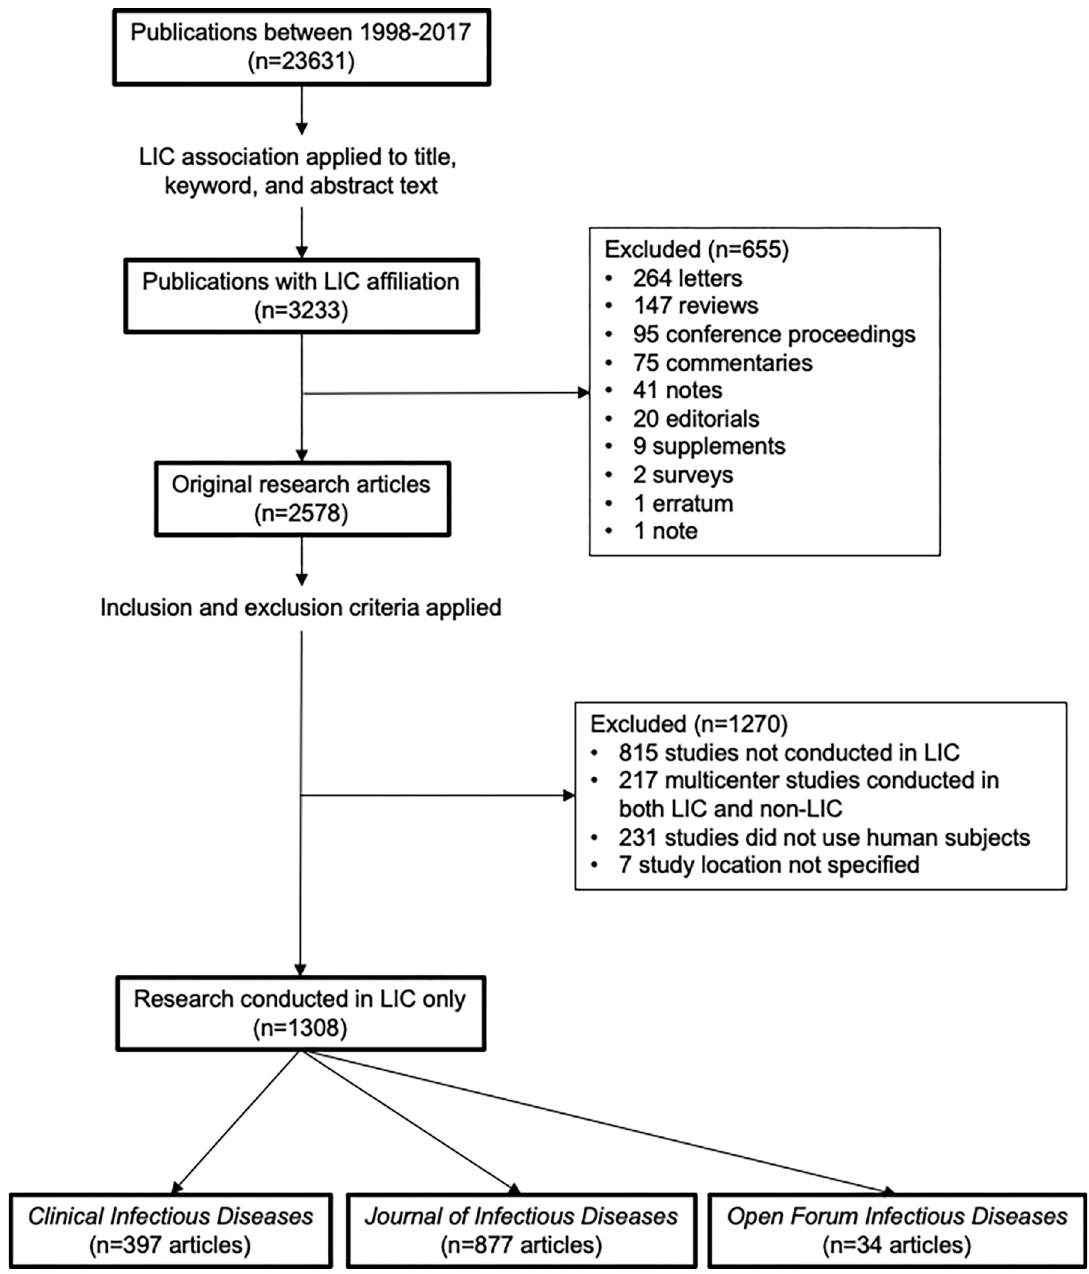
Fig 1. Methodology and inclusion/exclusion criteria. Criteria were applied and accessed via Scopus abstract and citation database search strategy. Abbreviations: LIC, low-income